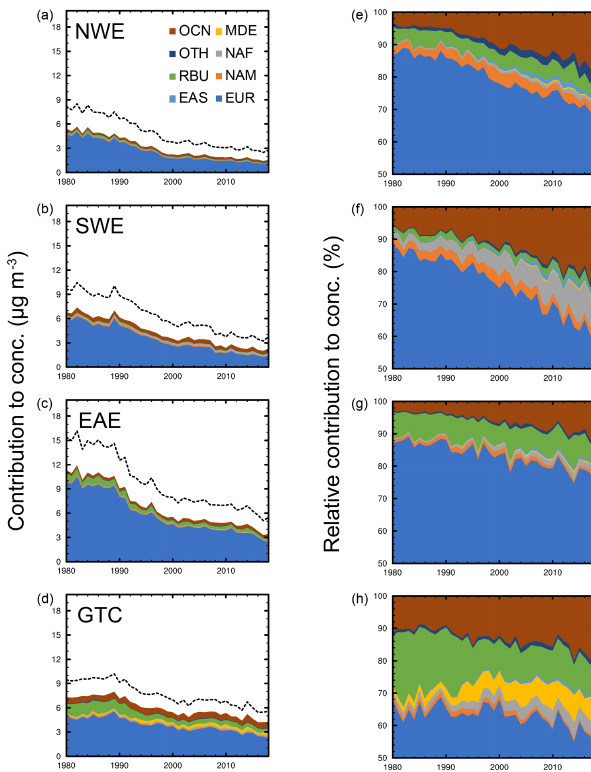
Figure 7. Time series (1980–2018) of absolute ( a, b, c, and d ; in micrograms per cubic meter) and relative ( e, f, g, and h ; in percent) contributions of emissions from major source regions to the simu- lated annual mean near-surface sulfate-BC-POA concentrations av- eraged over the four subregions of Europe. Dashed lines in panels (a–d) represent simulated aerosol concentrations including SOA.